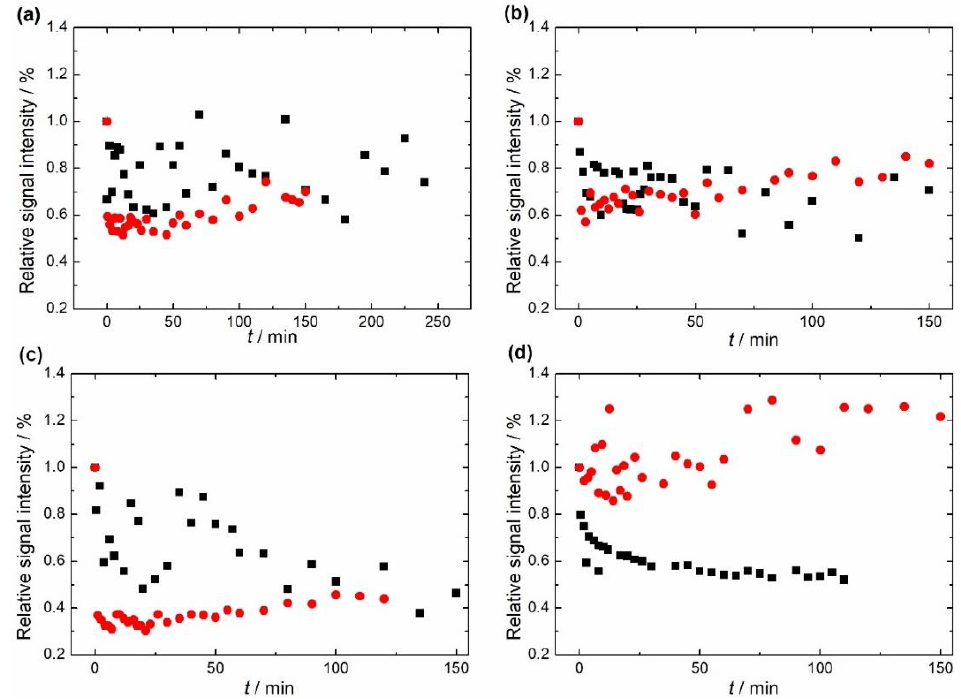
Figure 7. Dependence of the double integral of EPR spectra of non-substituted hydroxyapatite (HAP), black squares, and Mg-substituted HAP (Mg-HAP), red circles, at ( a ) 343 K, ( b ) 353 K, ( c ) 363 K and ( d ) 373 K.